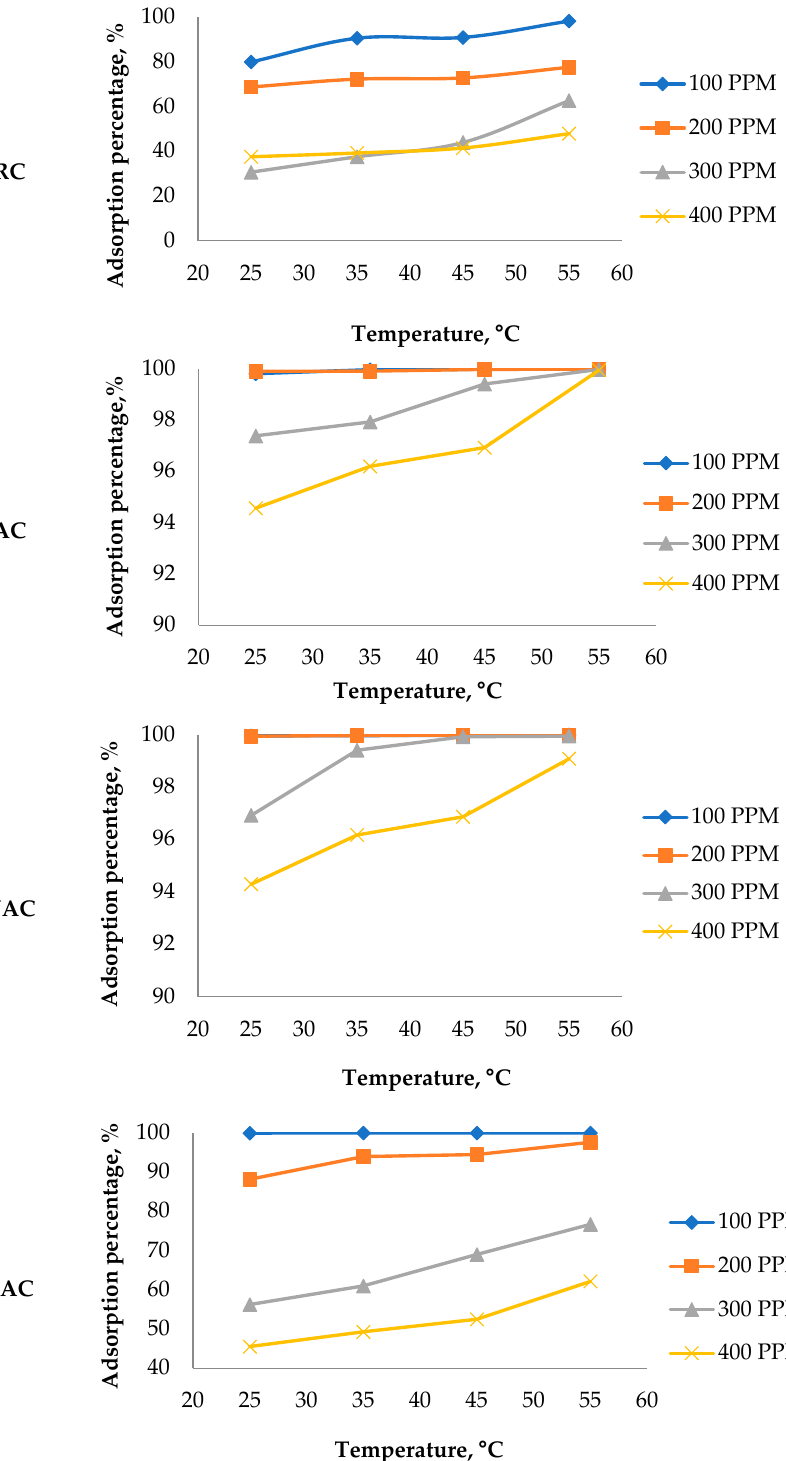
Figure 8. Plot of the ofloxacin adsorption percentage against temperature as a function of the initial concentration of the ofloxacin solution for different cassava stem adsorbents (condition: pH 5; contact time = 180 min; adsorbent dosage = 1.5